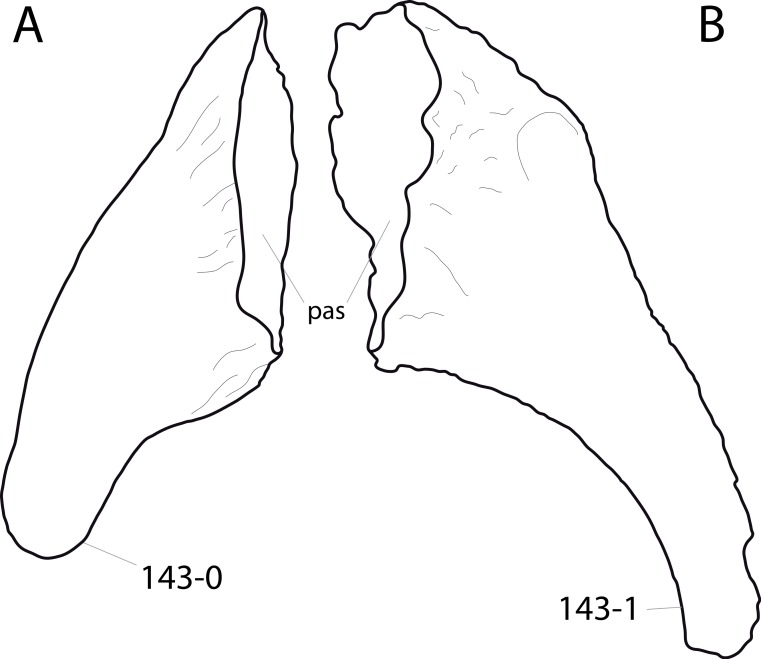
Diplodocine proatlases.Proatlas of ?Kaatedocus SMA P29-1 (A) and Galeamopus sp. SMA 0011 (B) in medial view, illustrating the broad (A; C143-0) and narrow distal tips (B; C143-1). Abb.: pas, proximal articular surface. Scaled to the same articular surface height.